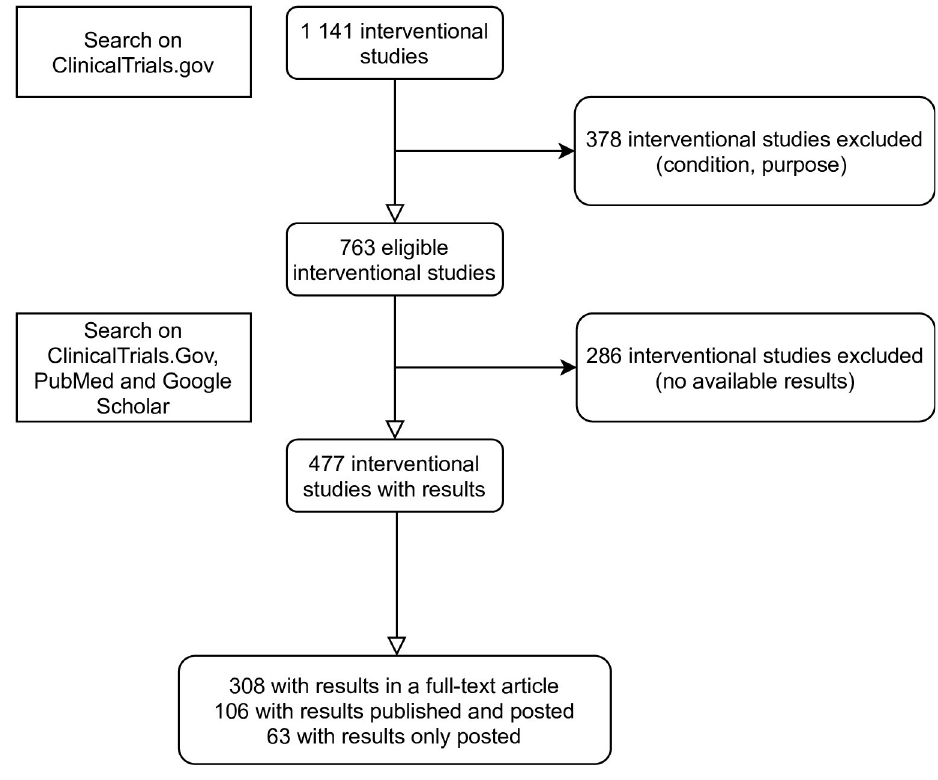
Fig 1. Flow chart of our